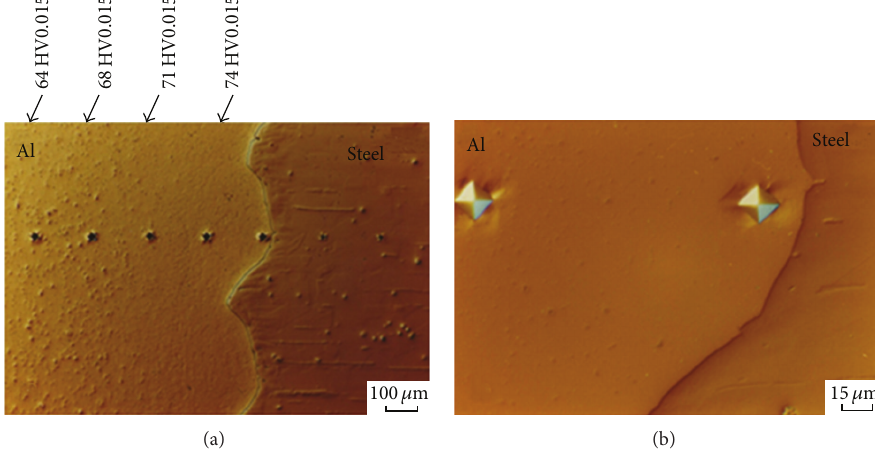
Figure 9: The microstructure in the bonding zone of the friction welded AlMg3 aluminium alloy-X10CrNiTi189 austenitic steel (steel sample with a rough surface of 𝑅 𝑧 = 150 𝜇 m) (a) and an enlarged fragment of the microstructure from Figure 9(a) (b).